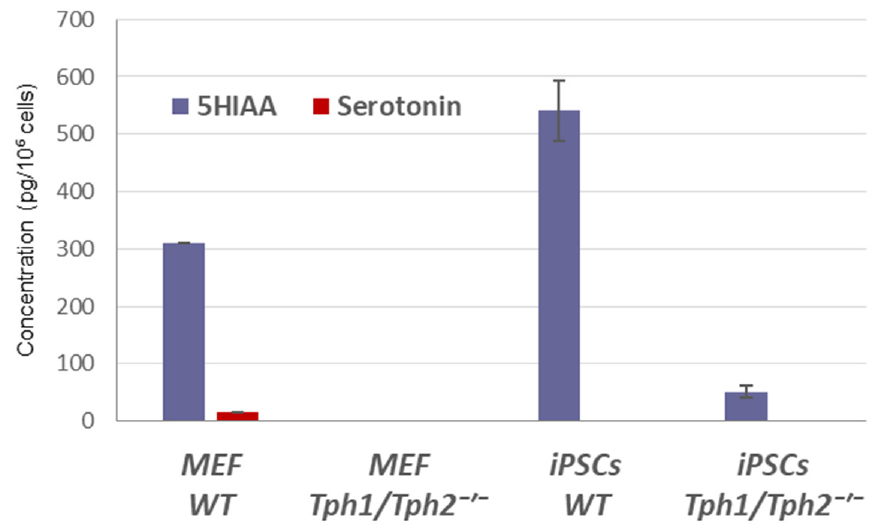
Figure 4. Intracellular serotonin metabolite 5-HIAA levels depend on TPH activity. Serotonin and 5-HIAA levels in cell lysates from wild-type (WT) and Tph1/Tph2 − / − MEFs, as well as from iPSC counterparts, cultured in 10% FBS-containing MEF medium or serum-free N2B27-2i medium, respectively. Y -axis represent concentration (pg/10 6 cells) ± SD; n = 2 (technical replicates), p < 0.001.